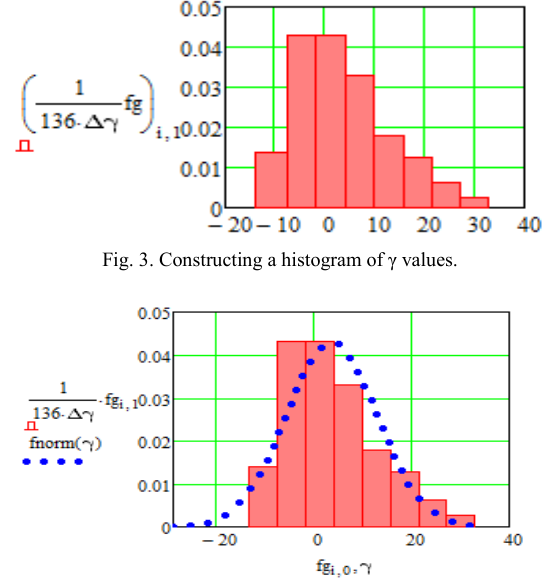
Fig. 4. Agreement verification of the theoretical Gaussian distribution with the statistical one according to the chi- squared test χ 2